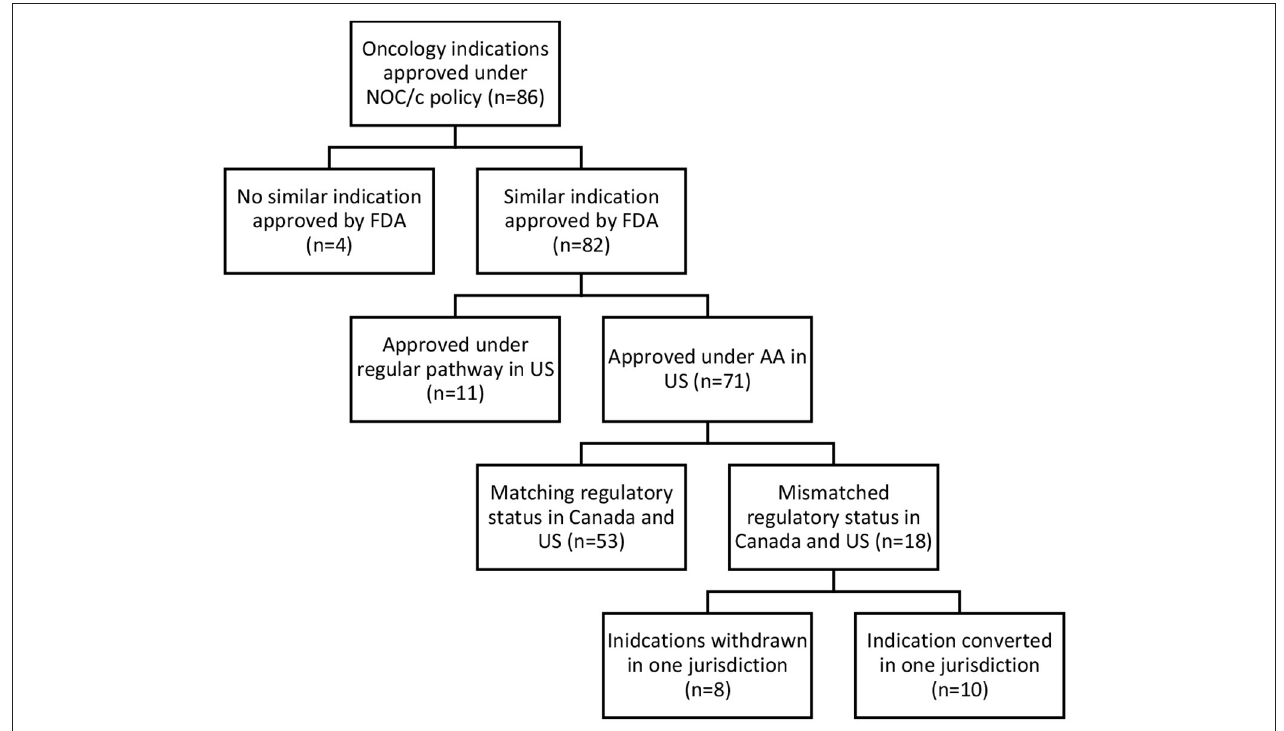
FIGURE 3 | Comparative regulatory status, Canada-United States.